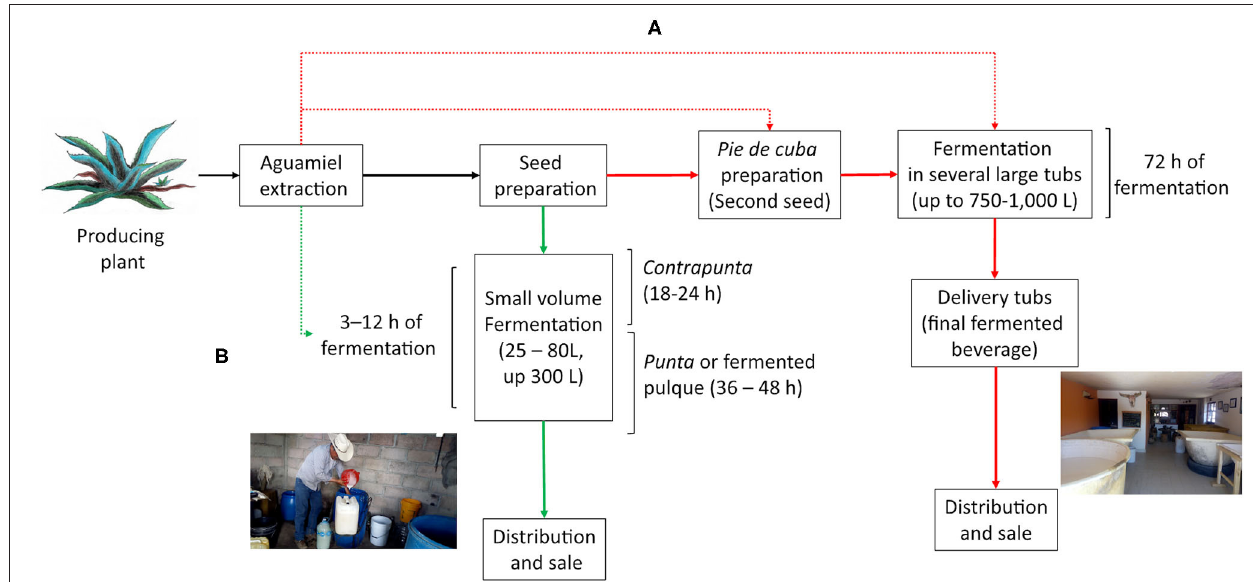
FIGURE 3 | Traditional pulque production flowchart. (A) Medium-large volume production process as described in section Types of Pulque and Properties. Dotted lines indicate pouring of freshly collected aguamiel to feed the pie de cuba and the fermentation tanks. (B) Small volume production process as described in section Types of Pulque and Properties. Dotted lines indicate freshly collected aguamiel to feed the fermentation tank. Contrapunta and punta are colloquial terms used by pulque producers to refer to an intermediate fermentation stage (contrapunta) and the final fermented pulque fermented ( punta ). This flowchart was elaborated from information reported in Crist (1939), Ramírez Rancaño (2000), Ramírez Rodríguez (2004), Escalante et al. (2016), Moreno-Terrazas et al. (2017), Álvarez-Ríos et al. (2020), and Rocha-Arriaga et al.